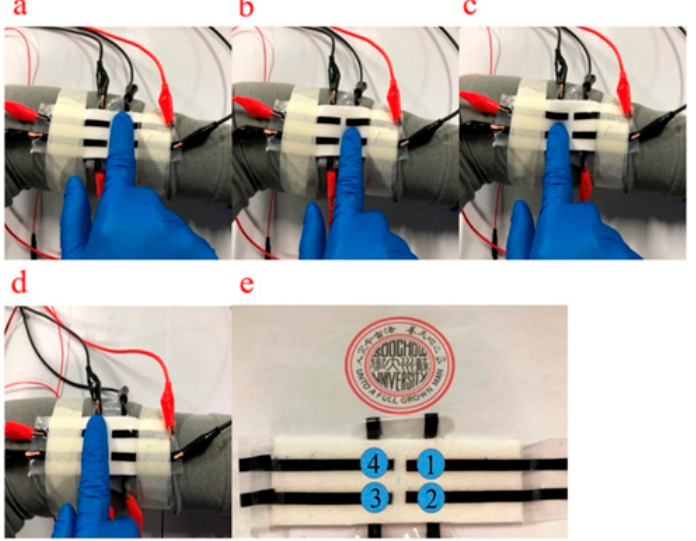
Figure A3. ( a ) Photo of the sensor before the compression test, ( b ) photo of the sensor under the compression test.